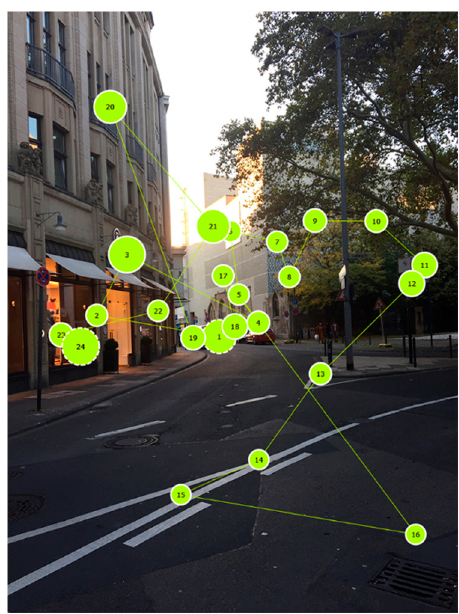
Figure 5. Gaze plot of the observation of image 1 by a single person.